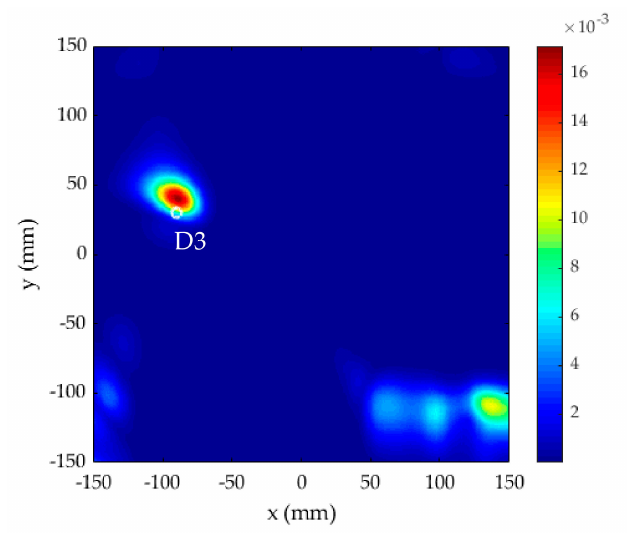
Figure 29. Aggregate damage image in pulse–echo configuration through